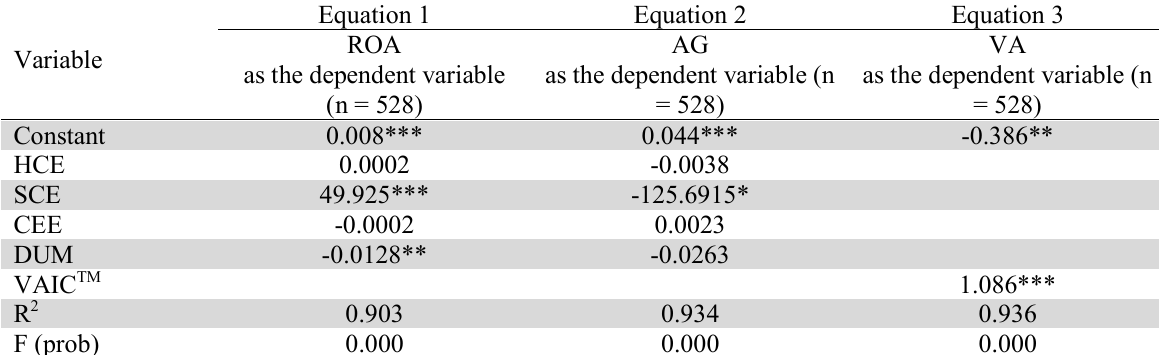
Results of Research